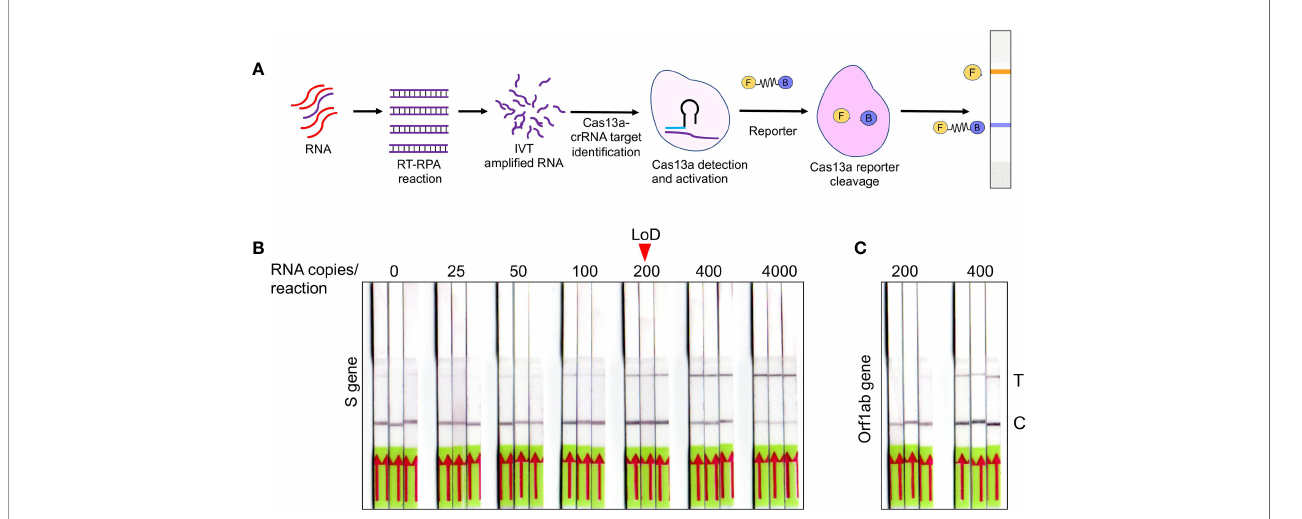
FIGURE 3 | Optimization of SHERLOCK-based detection on extraction free saliva samples (A) Schematic representation of various steps involved in SHERLOCK- based detection when the starting genetic material is RNA. Cas13a enzyme is used for the target recognition and reporter cleavage. For visual detection using LFA, RNA reporter molecule conjugated with 6-Carboxy fl uorescein (FAM) and biotin is used. (B) Images of paper-strips after lateral- fl ow assay obtained from spiked-in saliva samples using S gene standard RNA with a range from 0 to 4, 000 copies of RNA/reaction. A consistent detection of test lane signal was obtained in all three samples with 200 copies of RNA, which was considered as LoD for visual readout. (C) Similarly, Orf1ab standard RNA was subjected to LFA and paper-strip images were obtained. The LoD for Orf1ab was found to be higher than S gene at 400